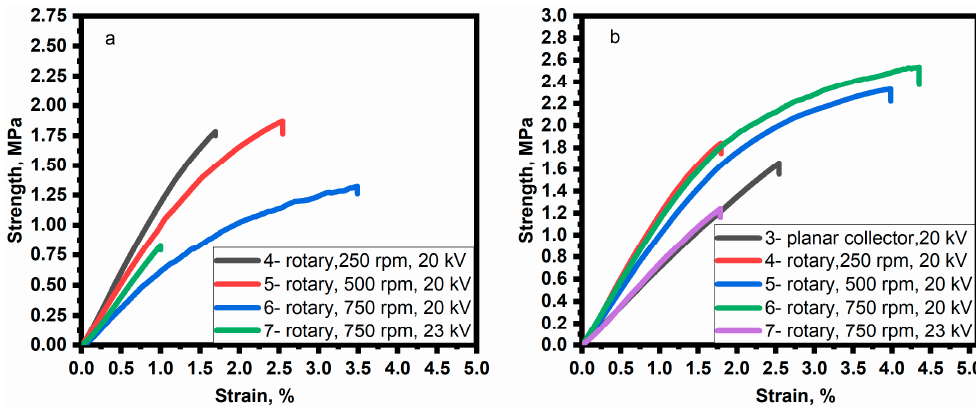
Figure 7. Tensile strength diagrams of specimens with a maximum tensile strength: ( a ) in the TD of the collector; ( b ) in the LD of the collector. Samples were made according to the following parameters: Sample 3 (20 kV, 150 mm, 0.72 mm, 0.3 mL/h, planar collector); Sample 4 (20 kV, 150 mm, 0.72 mm,